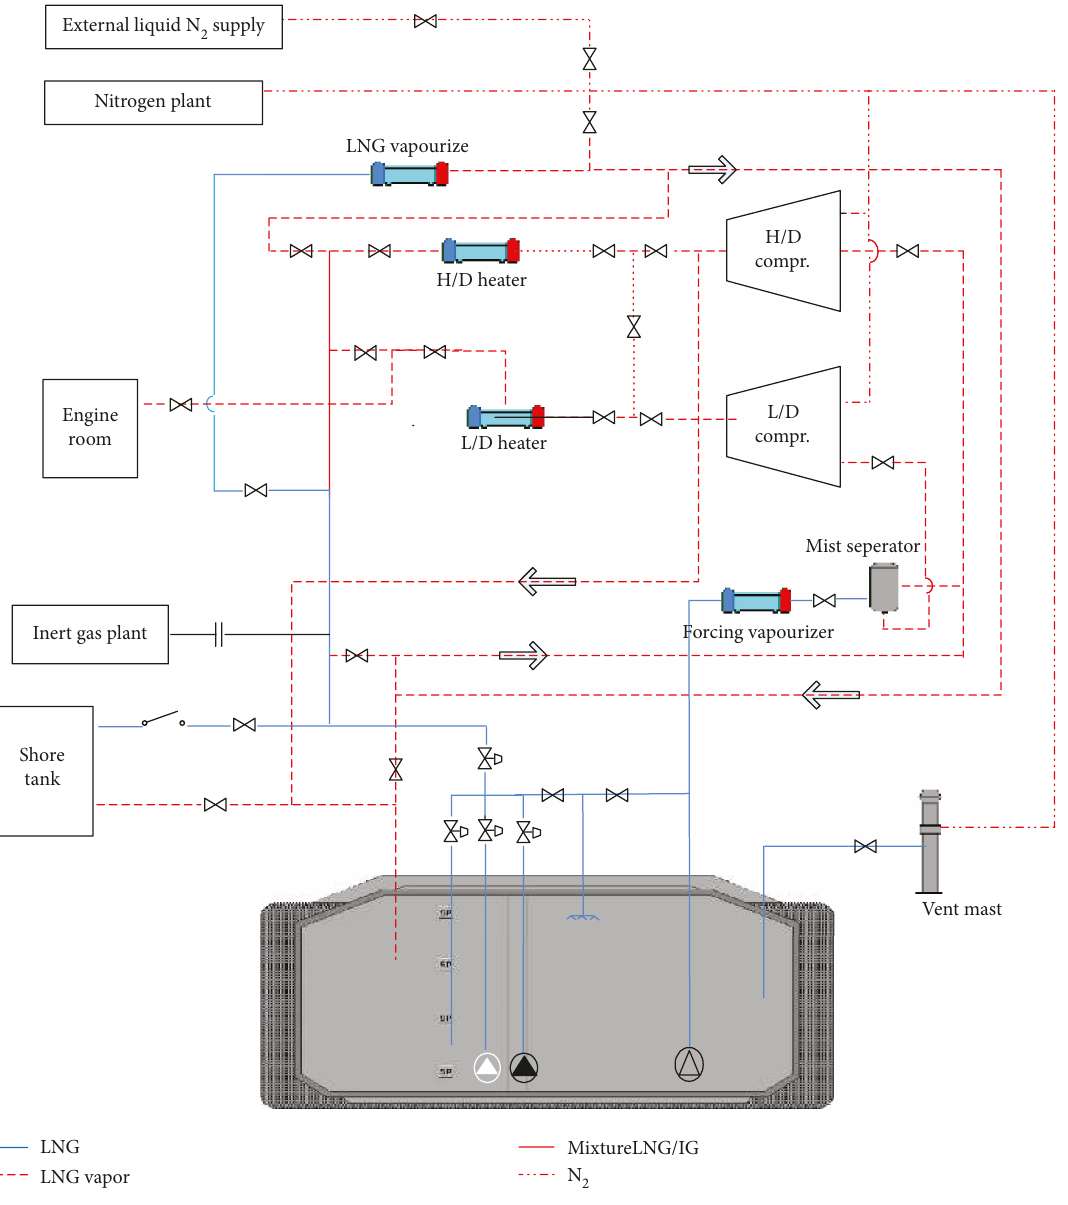
Figure 1: LNG cargo handling system